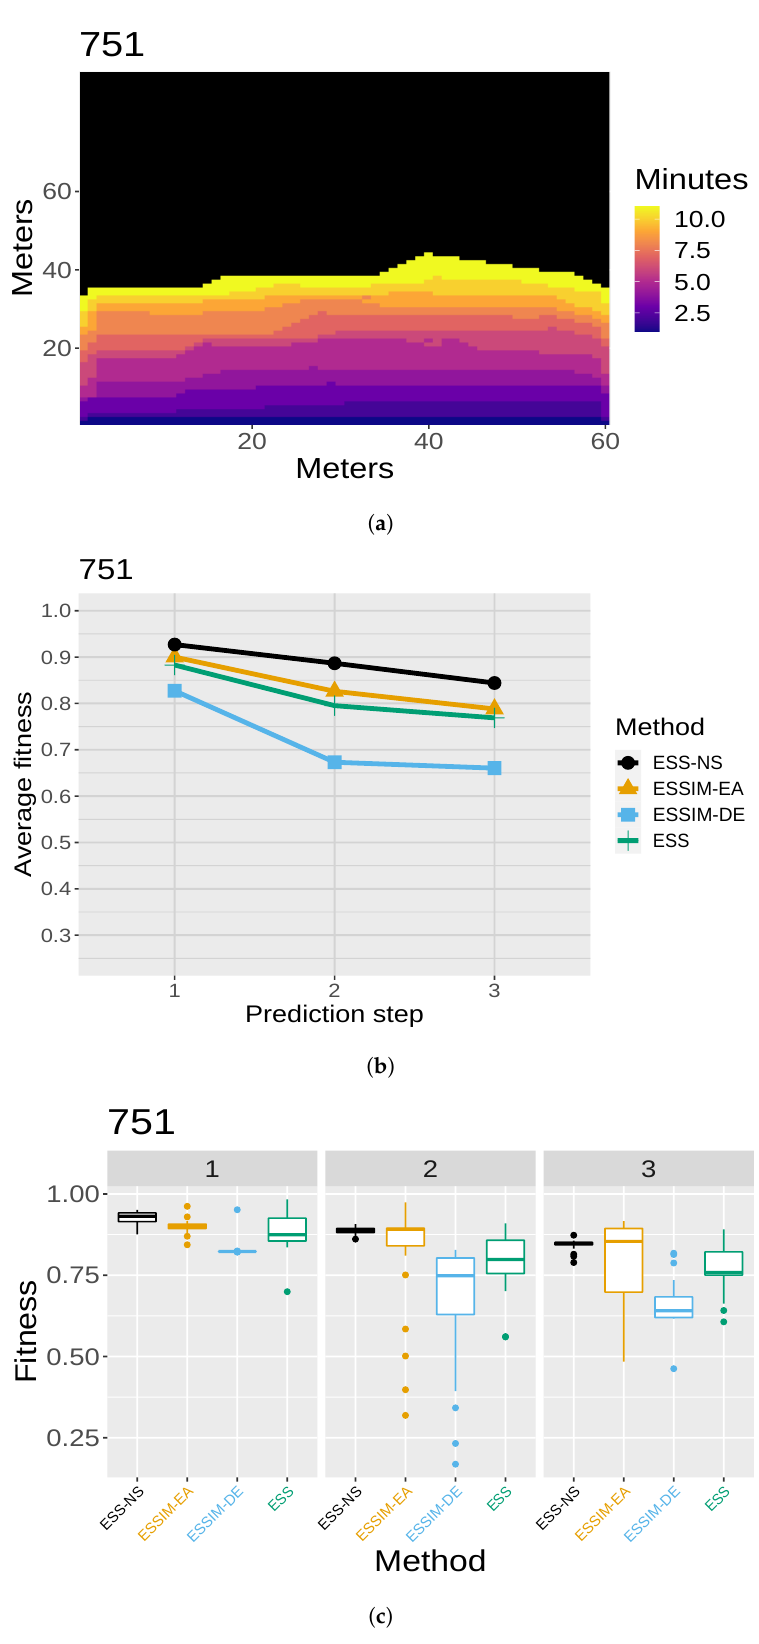
Figure 9. Case 751: ( a ) map of the real fire spread; ( b ) fitness averages; and ( c ) fitness